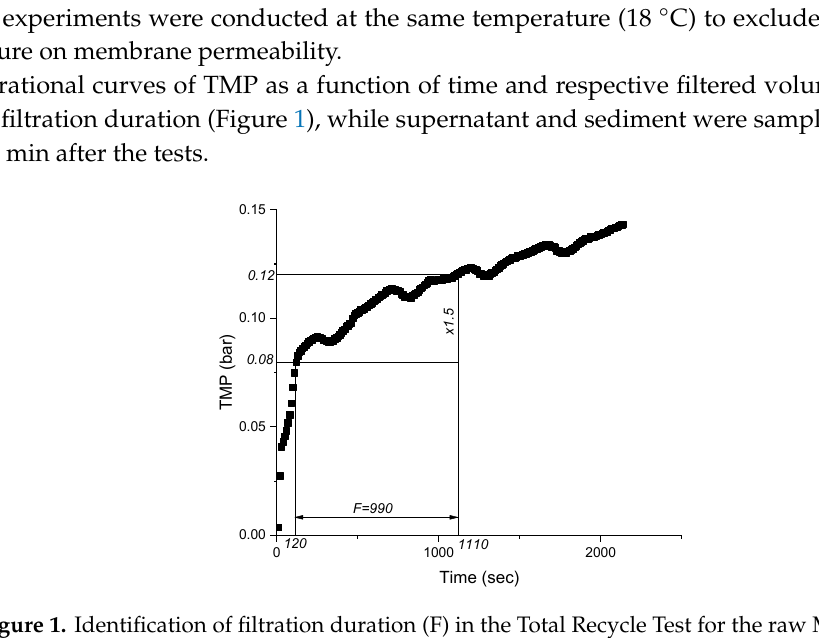
Figure 1. Identification of filtration duration (F) in the Total Recycle Test for the raw MBBR ML.